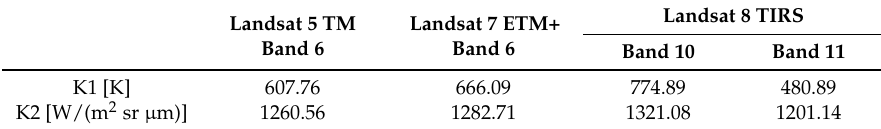
Table 2. Calibration constants used for effective at-satellite brightness temperature retrieval.